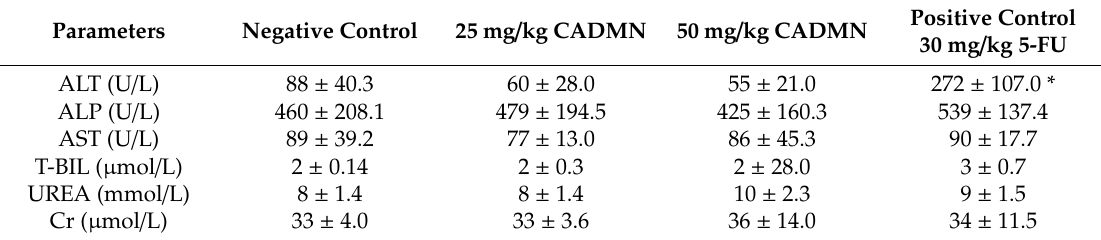
Table 1. Biochemical parameters analysis for liver function (ALT, ALP, AST, and T-bilirubin) and kidney function (creatinine and urea) parameters.